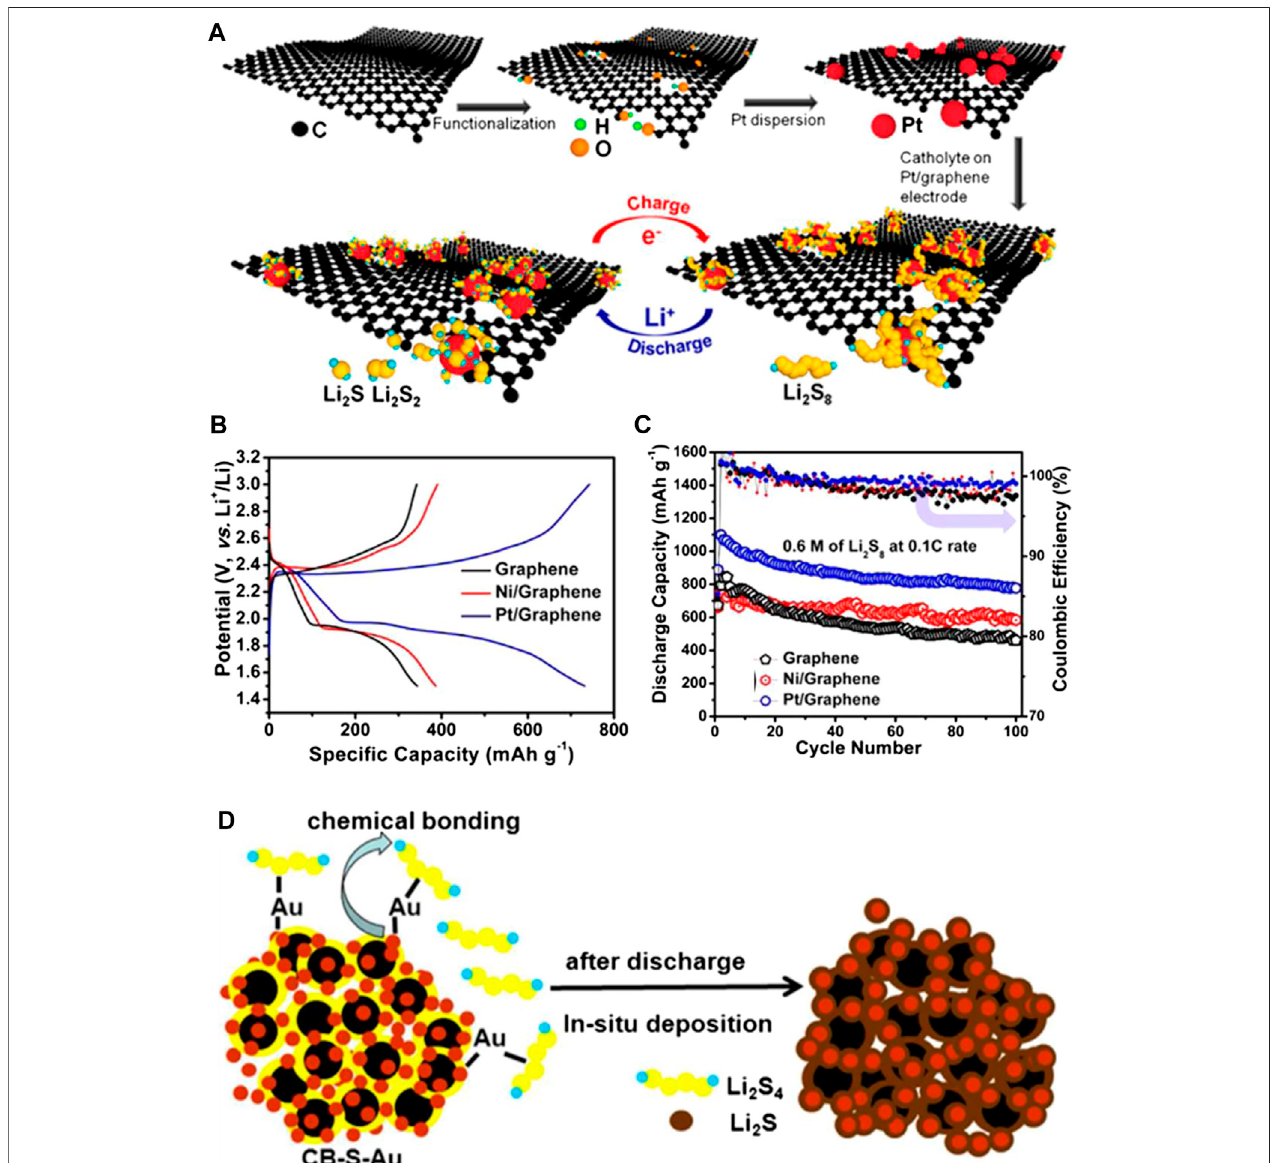
FIGURE 1 | (A) Schematic illustration of electrocatalyst-anchored graphene nanocomposite preparation and its interaction with PS during the charge/discharge process of the Li − S battery (B) voltage vs speci fi c capacity pro fi le and (C) galvanostatic charge/discharge behavior and Coulombic ef fi ciency of pristine and electrocatalyst-anchored graphene electrodes vs Li + /Li at 0.1 C rate in the potential range of 1.5 – 3.0 V. Reproduced with permission from Al Salem et al. (2015). Copyright © 2015American Chemical Society (D) The function mechanism of the CB-S-Au cathode. Reproduced with permission from Fan et al. (2015). Copyright © 2015 American Chemical